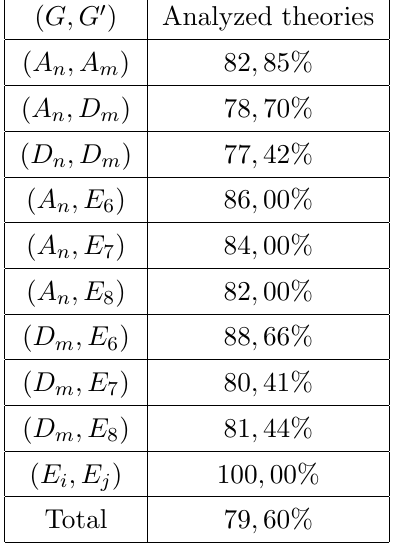
Table 1 . Percentage of theories for which the computation has terminated without being